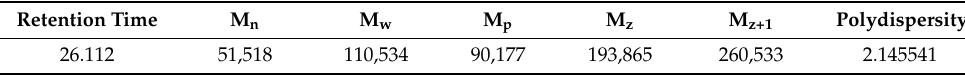
Table 2. GPC for chitosan sample after 120